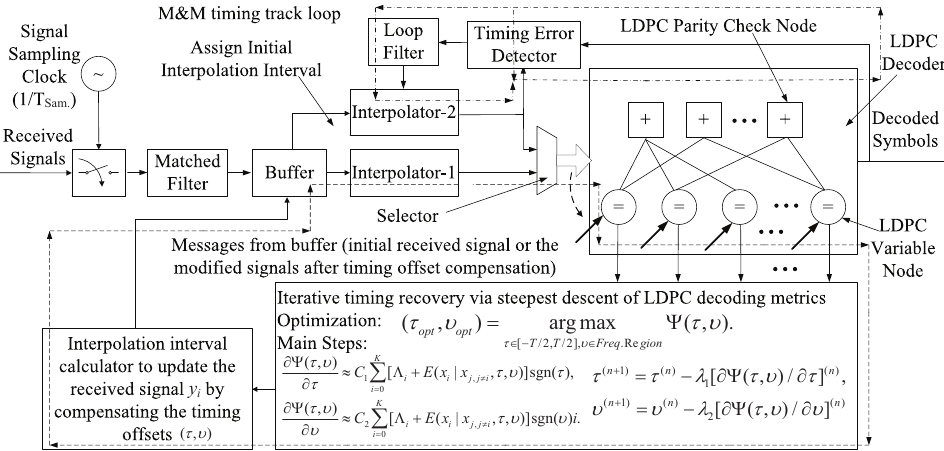
Figure 3. Block diagram of the whole timing recovery system by the proposed scheme via steepest descent of LDPC decoding metrics and the M&M timing